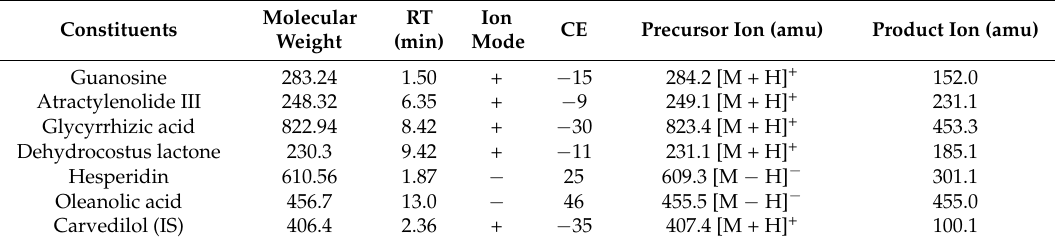
Table 1. The high-performance liquid chromatography–tandem mass spectrometry (HPLC-MS) conditions for identification of the six constituents and one internal standard.